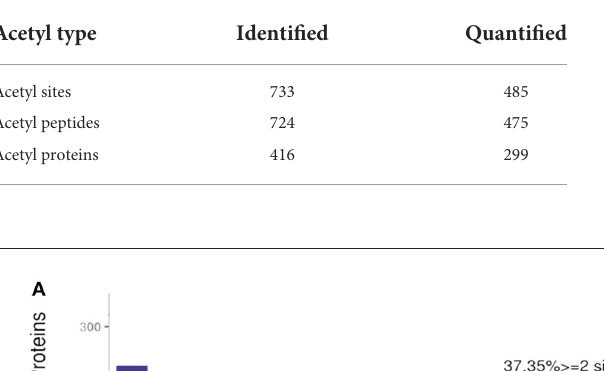
TABLE 1 Summary of quantified and identified lysine acetylation.